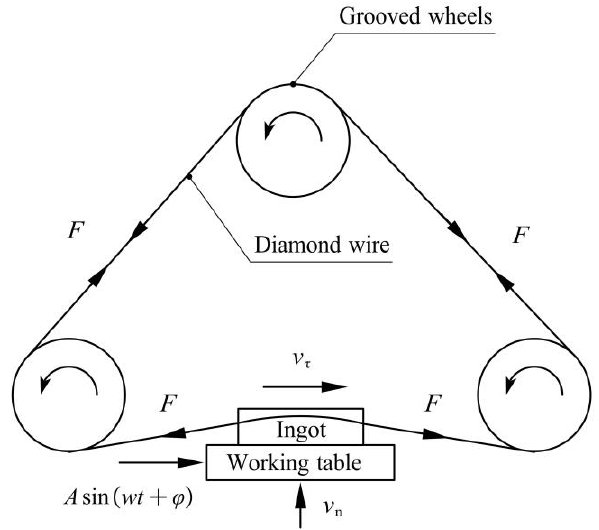
Figure 1. Schematic diagram of diamond wire saw.